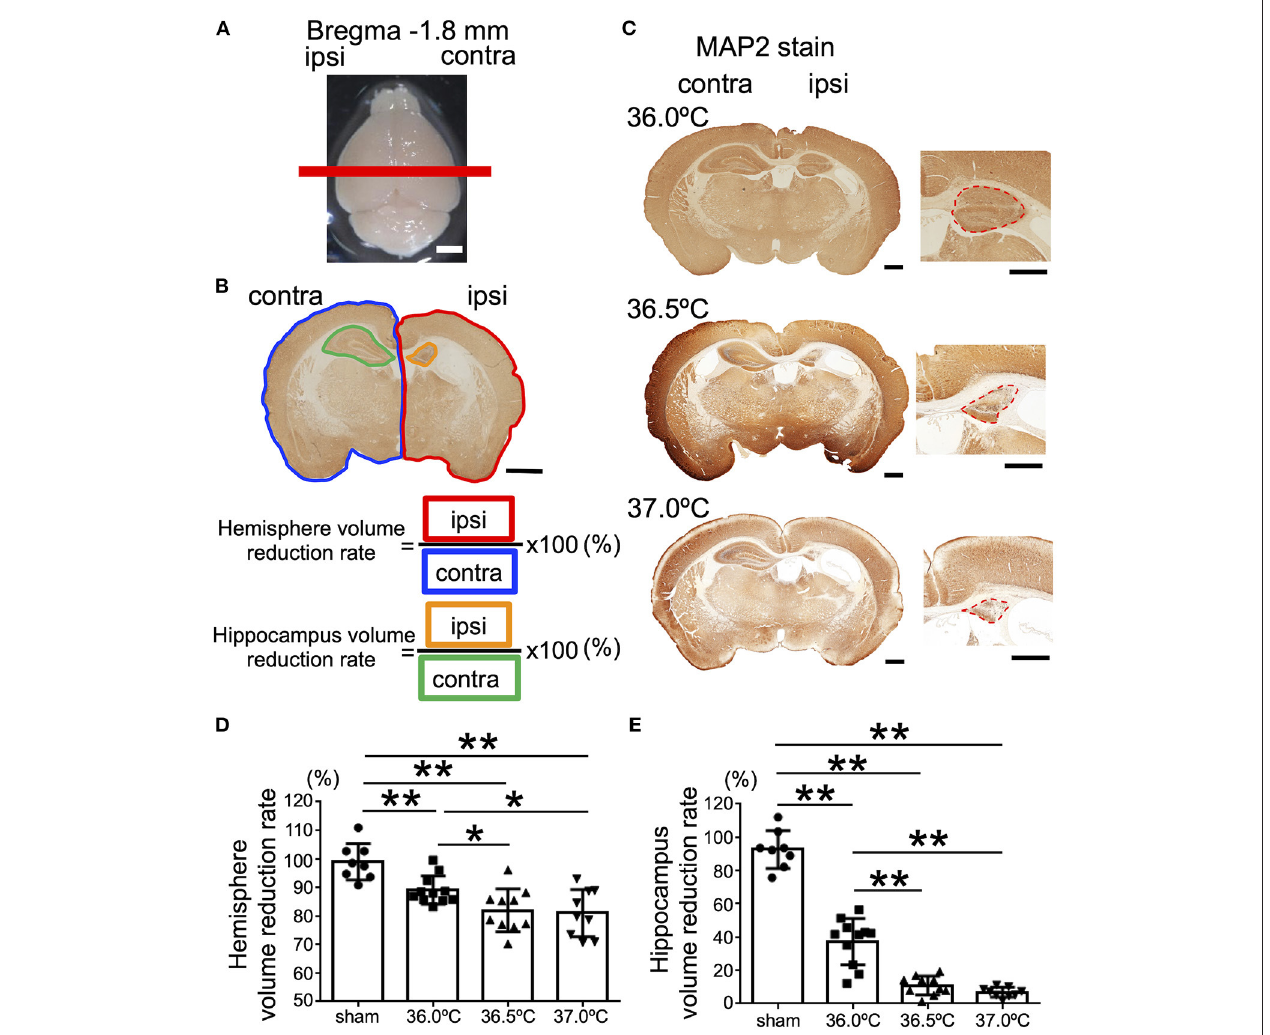
FIGURE 3 | Differences in cerebral volume loss at hippocampal position due to ambient temperature in HIE mice. (A) The red line shows the bregma − 1.8mm, which indicates the position where the brain was cut. Scale bar = 2mm. (B) Calculation method of cerebral volume loss. After MAP2 staining, the whole hemisphere volume reduction rate was calculated by dividing the whole ipsilateral hemisphere (area surrounded by red line) by the whole contralateral hemisphere (area surrounded by blue line). The volume reduction rate of the hippocampus was calculated by dividing the ipsilateral hippocampus (area surrounded by orange line) by the contralateral hippocampus (area surrounded by green line). Scale bar = 500 µ m. (C) MAP2 staining at hippocampal position 14 days after hypoxia at temperatures of 36.0, 36.5, or 37.0 ◦ C. Right panels are enlarged images of the hippocampal area in each temperature group. Red dotted lines show MAP2-positive staining areas. Scale bars = 500 µ m. (D,E) The volume reduction rate at the hippocampal position in the hemisphere (D) or hippocampus (E) (sham, •, n = 8; 36.0 ◦ C, (cid:4) , n = 11; 36.5 ◦ C, N , n = 10; 37.0 ◦ C, H , n = 9). * p < 0.05, ** p < 0.01. Error bars show means + SD. Ipsi, ipsilateral; contra, contralateral.